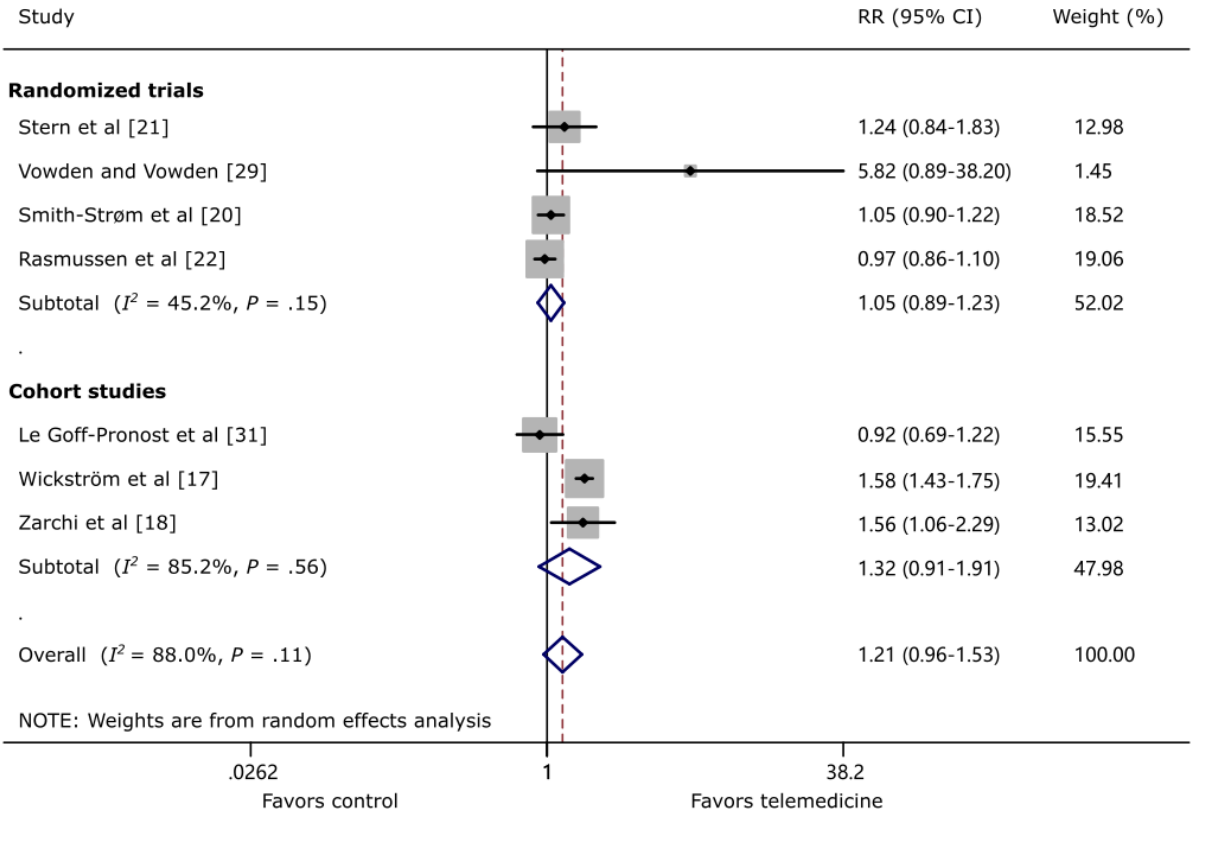
Figure 2. The effect of telemedicine on wound healing around 1 year. RR: risk ratio.